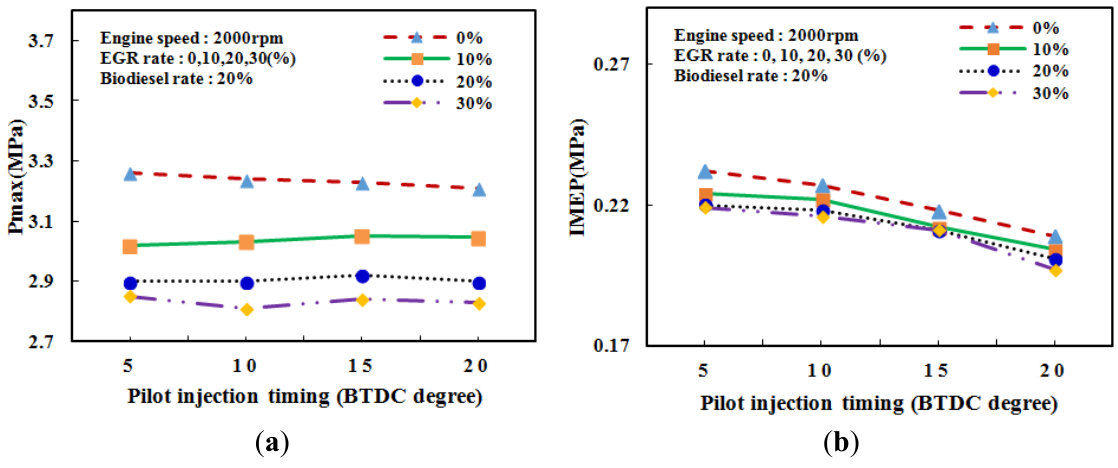
Figure 5. Effects of various pilot injection timings and EGR rates on the ( a ) P max and ( b ) IMEP.